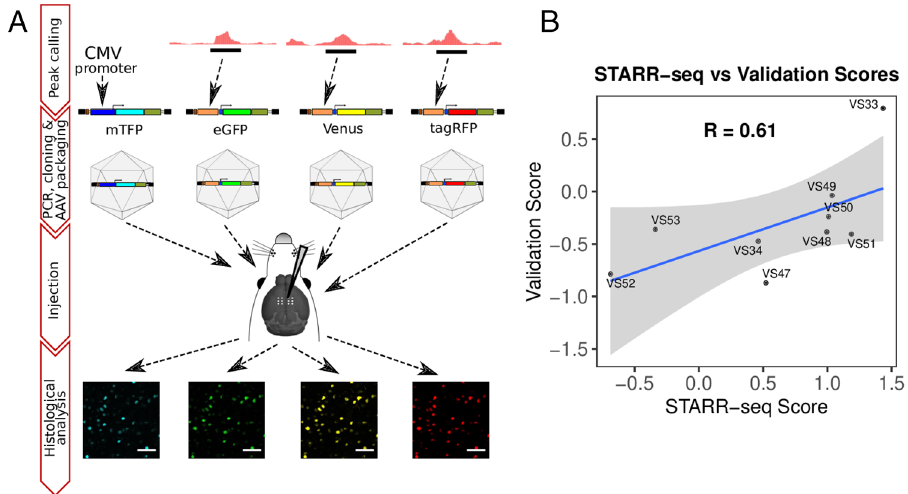
Figure 3. AAV-STARR-seq validation procedure. ( A ) Schematic illustrating AAV-STARR-seq validation procedure. ( B ) Scatterplot of AAV-STARR-seq screen signal (RNA/input DNA log2 fold change, averaged across mice) and fluorescence microscopy-based validation signal (log10 median relative fluorescence strength compared to CMV promoter; see Fig. 4) for 9 validation candidates with varying predicted enhancer